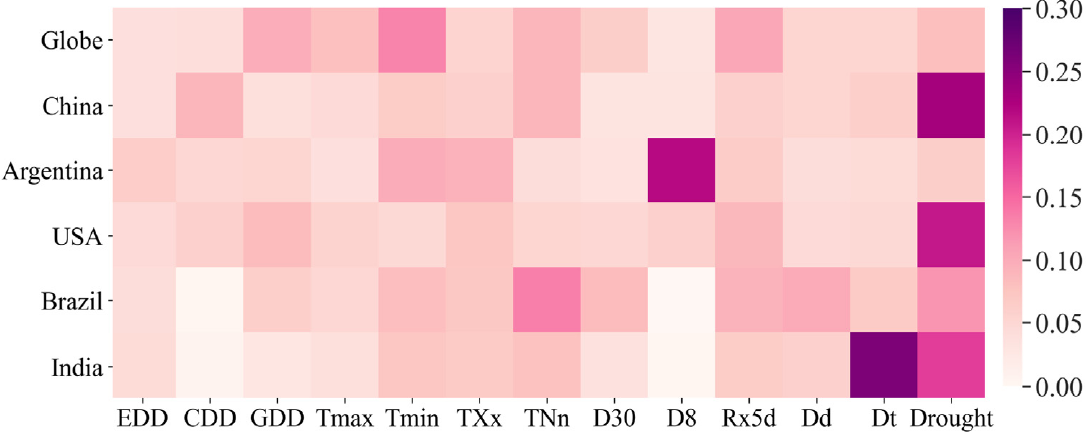
Figure 5. Heat map of extreme climate indicators’ importance for soybean yield.